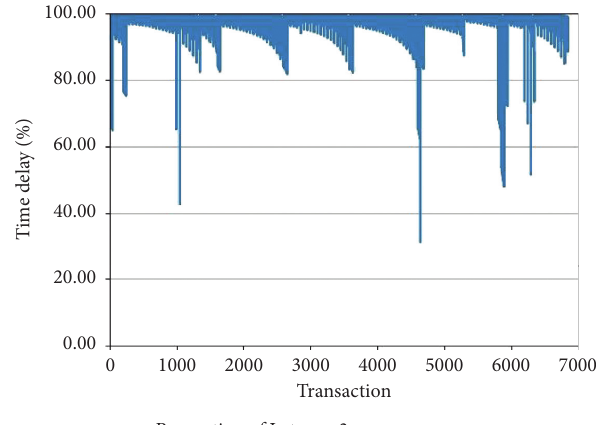
Figure 9: Proportion of Latency 1.